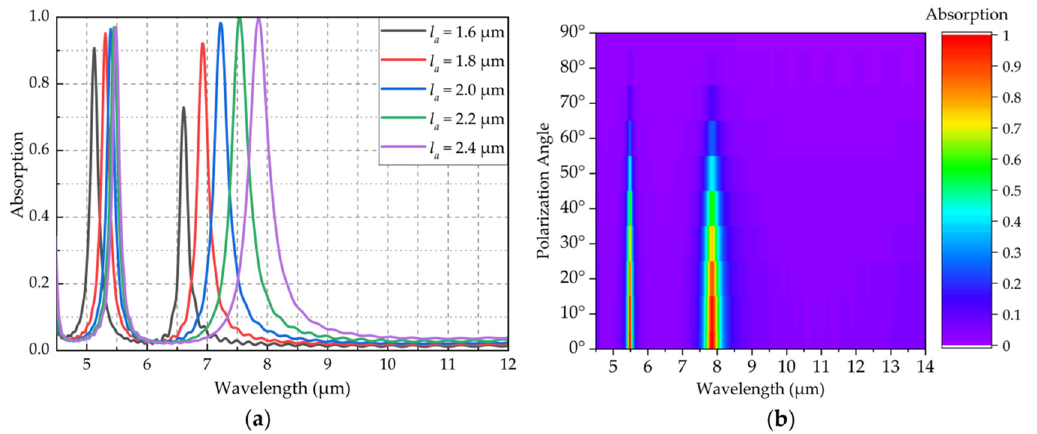
Figure 7. Calculated absorption spectra of: ( a ) Different l a with fixed l b = 0.1 μ m; ( b ) different polarization angles.